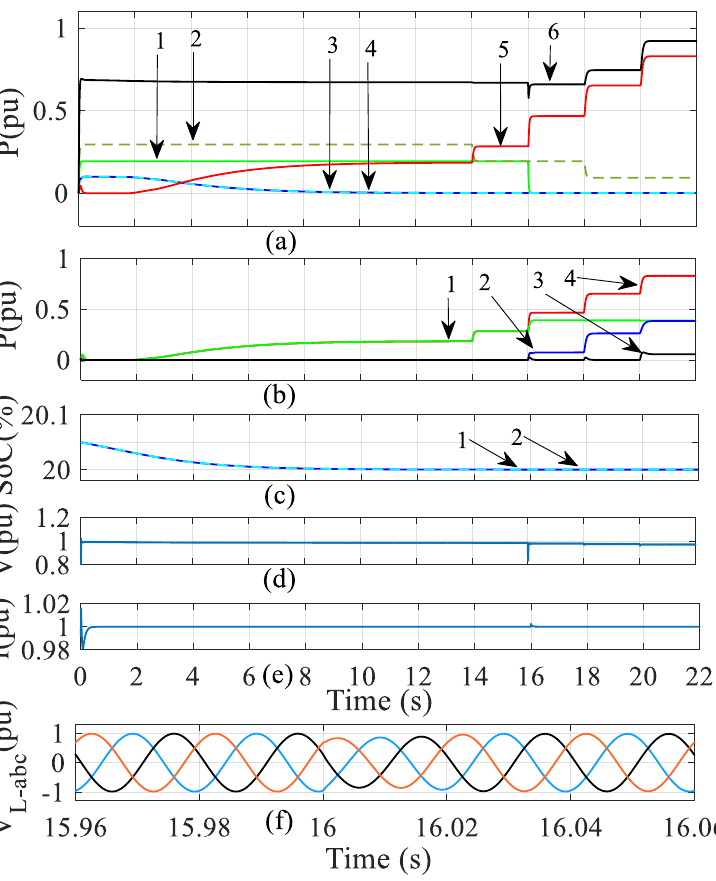
Figure 6. Reaching the min. SoC limit, experiencing a sudden large load change and experiencing sudden large generation loss. ( a ) Power (pu), 1 — P pv 1 ; 2 — P pv 2 ; 3 — P b 1 ; 4 — P b 2 ; 5 — P g ; 6 — P L . ( b ) Power from MGSCs (pu), 1 — P g 1 ; 2 — P g 2 ; 3 — P g 3 ; 4 — P g . ( c ) SoC (%), 1 — SoC 1 ; 2 — SoC 2 ; ( d ) V L (pu). ( e ) Load frequency (pu). ( f ) Instantaneous 3-phase load voltage zoomed-in at large generation change ( t = 16 s) time (pu).